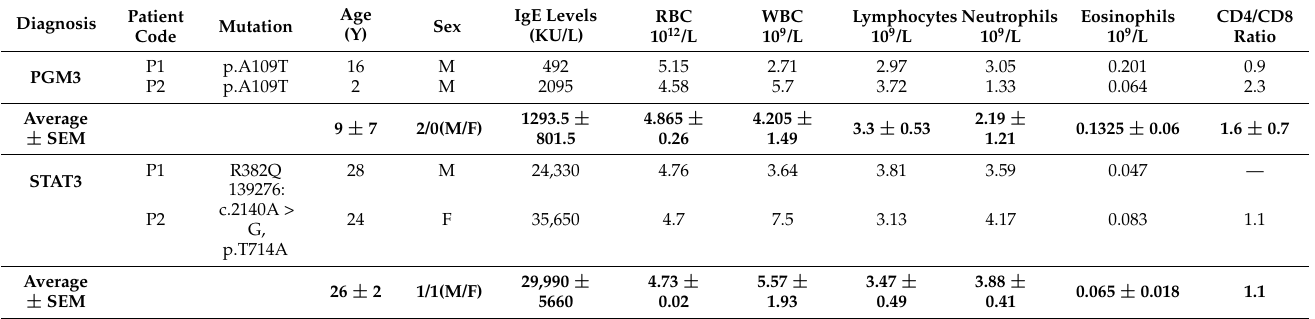
Table 1. Summary of laboratory findings in the patients with PGM3 and